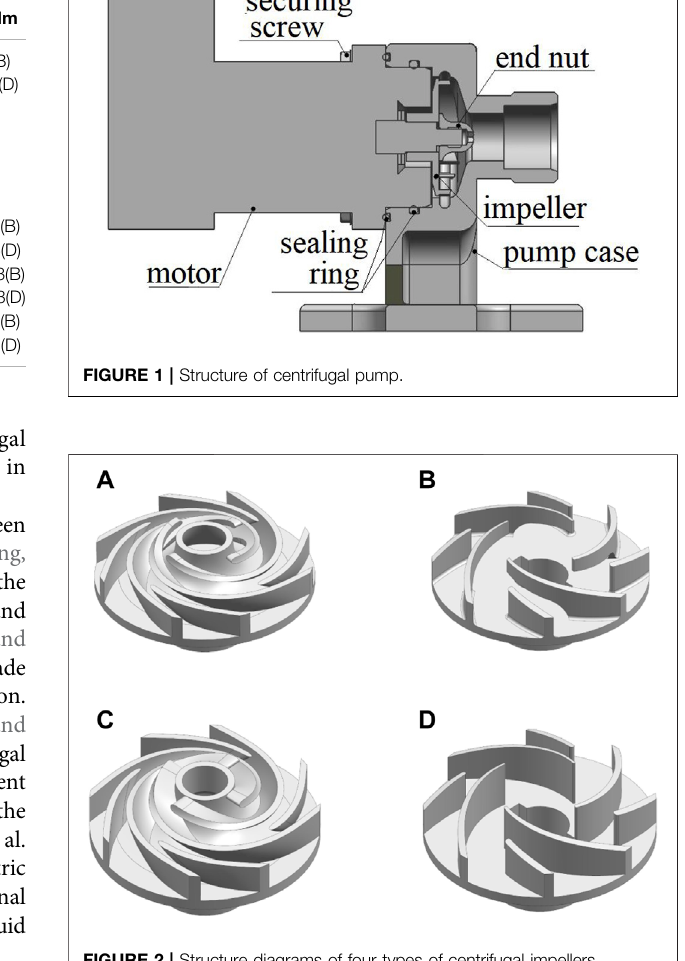
FIGURE 2 | Structure diagrams of four types of centrifugal